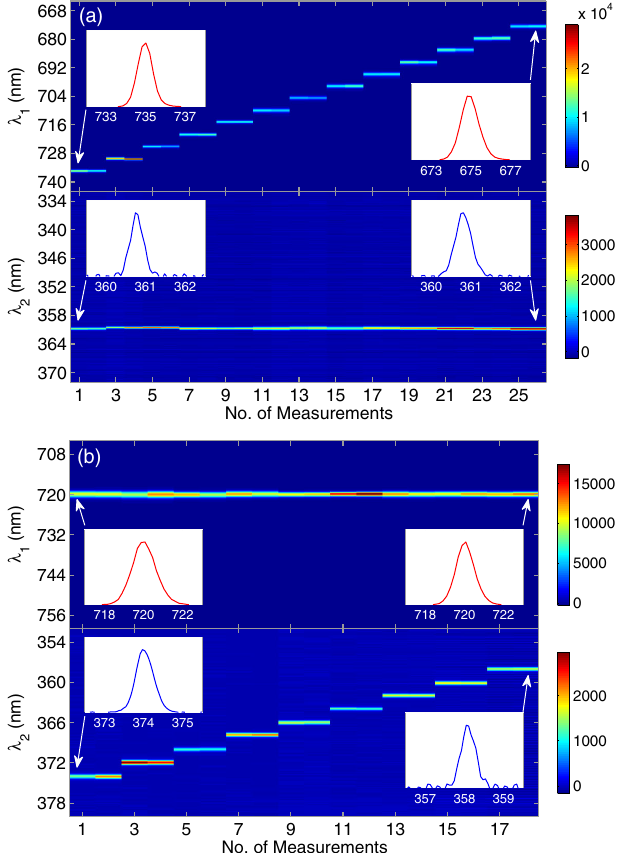
FIG. 3. Tuning of the (a) IR and (b) UV wavelength of the two- color lasing with the four-undulator configuration and loss curves L2 (Run 3). In (a), the IR lasing ( λ 1 ) is shown to be tuned from 734.97 nm to 674.93 nm ( Δ λ 1 ¼ 60 . 04 nm) while fixing the UV lasing ( λ 2 ) around 360 . 69 (cid:2) 0 . 08 nm. In (b), λ 2 is tuned from 374.02 nm to 358.10 nm ( Δ λ 2 ¼ 15 . 92 nm) while keeping λ 1 around 720 . 06 (cid:2) 0 . 07 nm. The beam current is maintained between 12.03 mA and 12.78 mA in both (a) and (b).